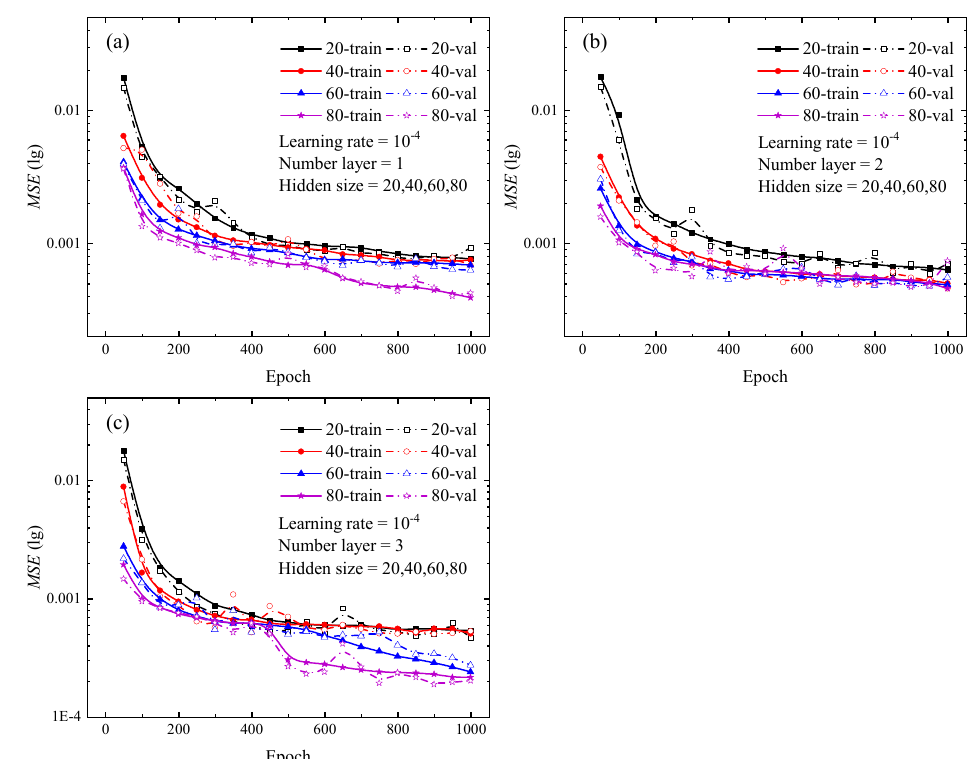
Figure 5. Loss curves of different hidden sizes during the training and validating phrases for indentation predictions. ( a ) The number of hidden layers is 1; ( b ) The number of hidden layers is 2; ( c ) The number of hidden layers is 3. In the legend, the cases of 20, 40, 60 and 80 represent the number of hidden sizes the LSTM neural network.